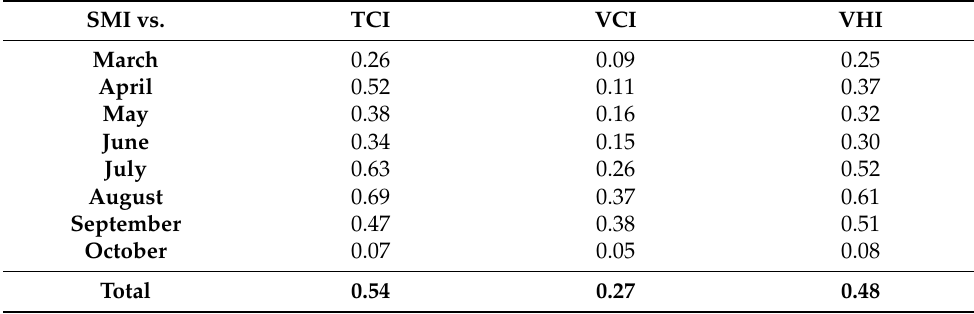
Table 5. Bravais-Pearson correlation coefficients between Soil Moisture Index (SMI) and the MODIS- based drought index data sets for the complete time series from 2001 to 2020 (monthly and total). All correlation coefficients are statistically significant ( p -value < 0.05). The corresponding scatterplots for the complete time series (March to October) are included in Figure